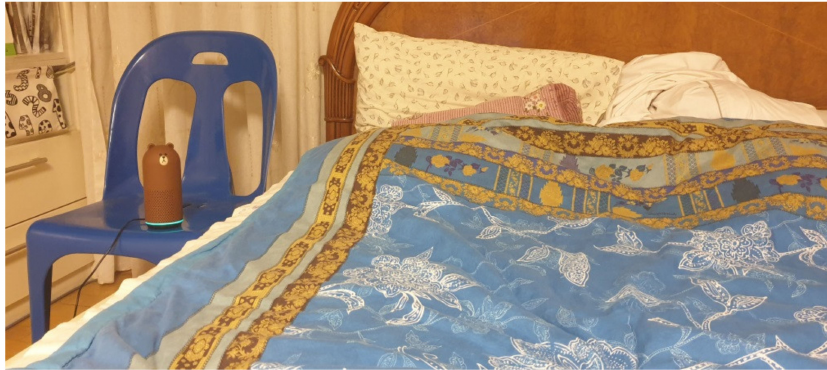
Figure 1. Conversational agent Clova with its green LED turned